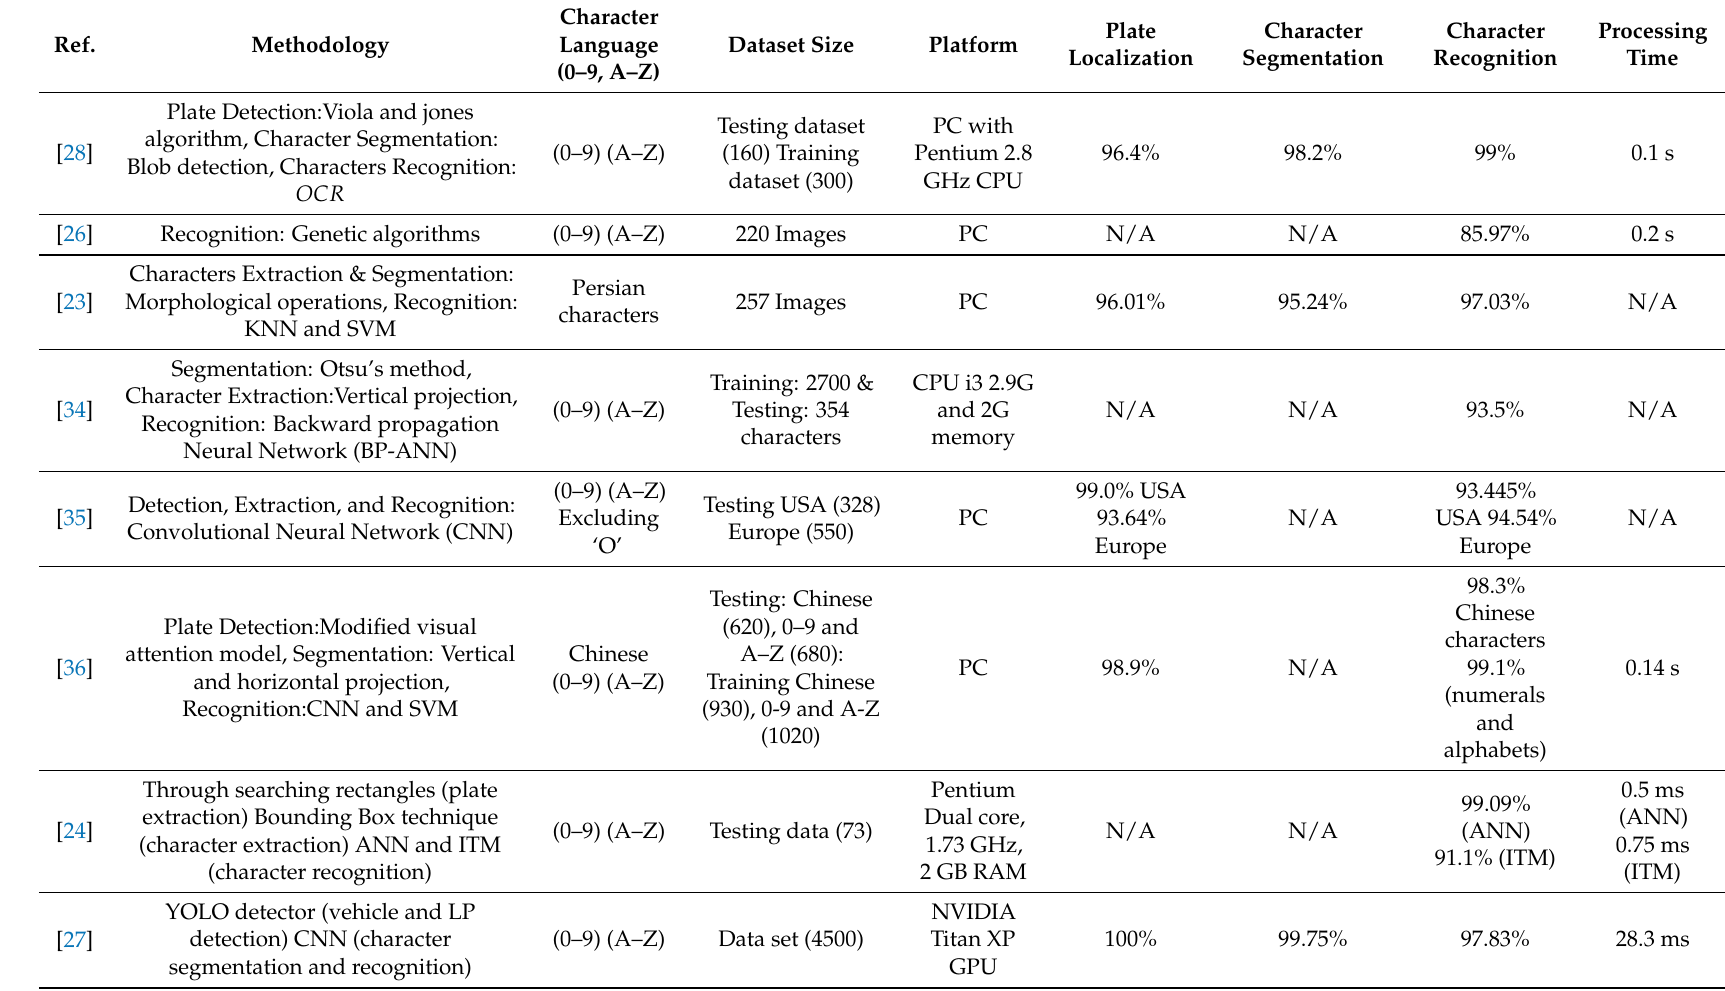
Table 1. Literature summary of LP detection, extraction, characters segmentation, and characters